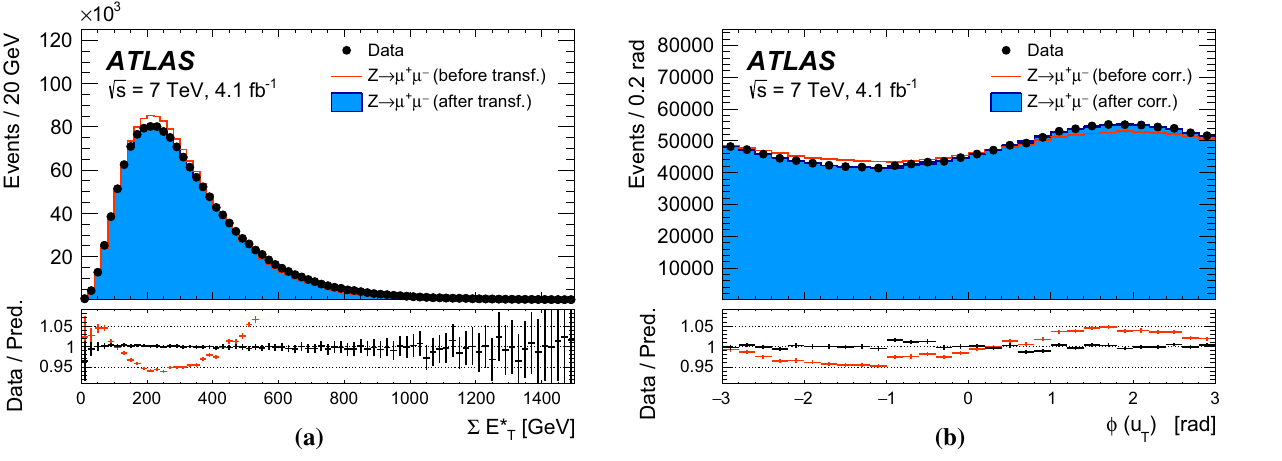
φ distribution is shown before and after the u Fig. 11 Distributions of a (cid:11) E ∗ and b azimuth φ of the recoil in data T and simulation for Z → μμ events. The (cid:11) E ∗ panels show the data-to-prediction ratios, with the verticalbars showing distribution is shown T the statistical before and after applying the Smirnov-transform correction, and the